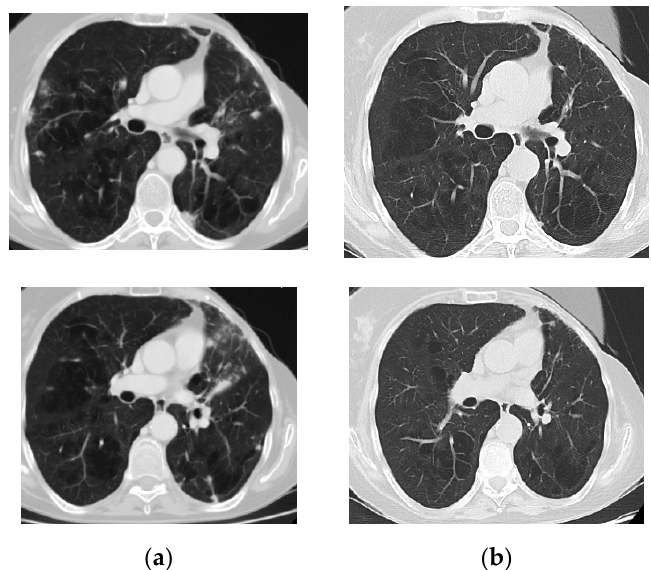
Figure 2. Axial CT scan of a lung window; ( a ) before treatment—large cavity, 40 × 70 mm in size, with irregularly thickened wall (black arrow) and multiple lung nodules up to 20 mm in size in both lungs; ( b ) after treatment—the cavity in the upper left lobe slightly diminished with the reduction of its wall thickness and regression of nodular opacities in both lungs.